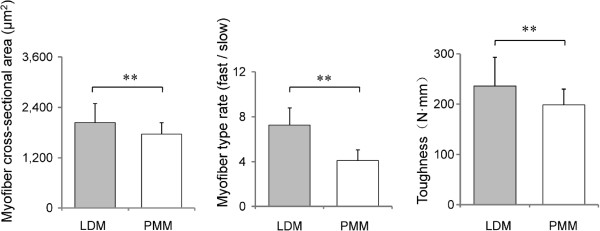
Phenotypic differences between the two distinct muscles. LDM, longissimus dorsi muscle; PMM, psoas major muscle. Statistical significance was calculated by one-way repeated-measures ANOVA (n = 3). ** P < 0.001.